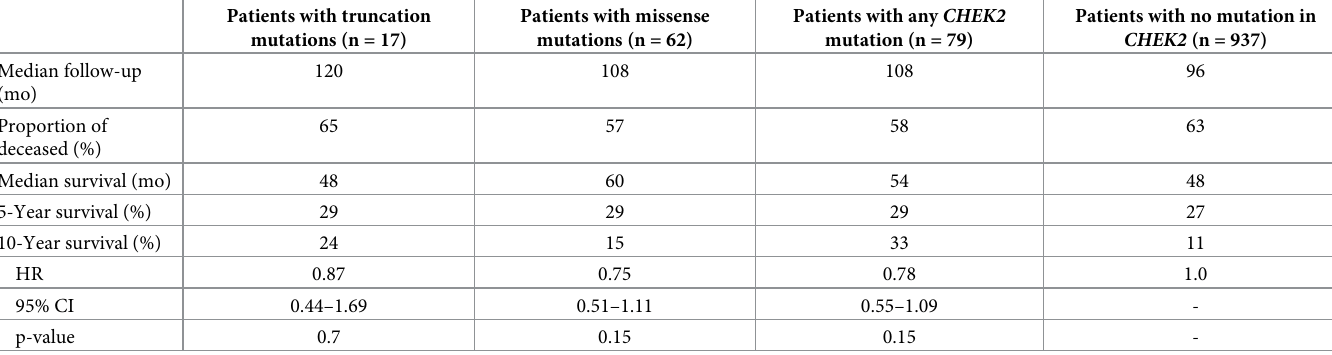
Hazard ratio (HR), 95% confidence interval (CI), and p-values are calculated by cox ph test. Data was stratified for age, sex, clinical characteristics, smoking status and cancer family